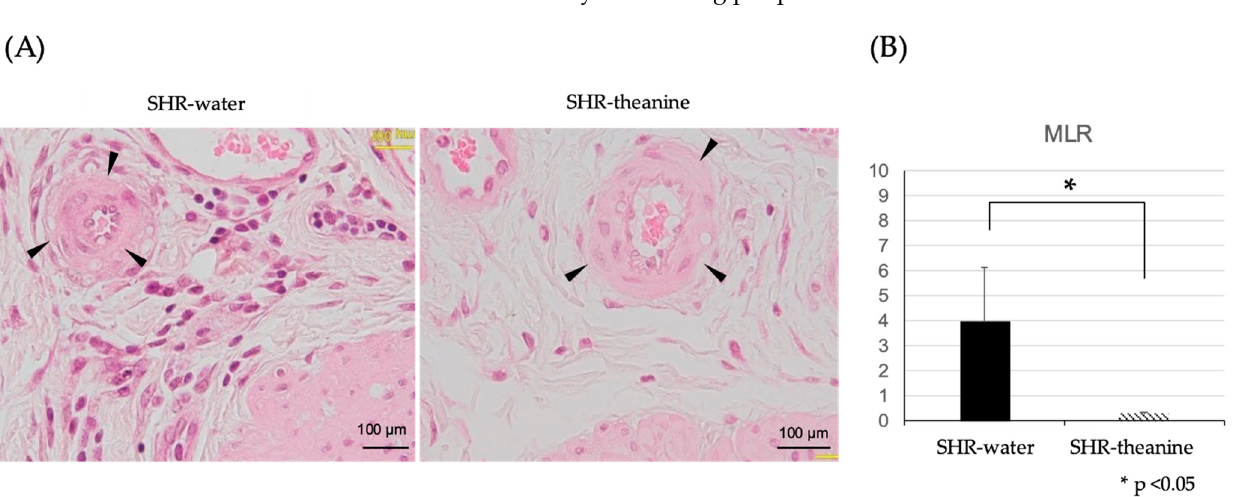
Figure 5. Summary of bladder oxidative levels in SHR treated with water and treated with L-theanine: ( A ) relative MDA protein levels in bladder and Western blots. Protein expression level of the bladder was significantly lower in the SHR– theanine group than in the SHR–water group. * Statistical significance at the p < 0.05 level; ( B ) immunohistochemical staining of the bladder in SHR–water and SHR–theanine groups, scale bars = 200 µm. Expression of MDA in the bladder was weaker in the SHR–theanine group than in the SHR–water group.